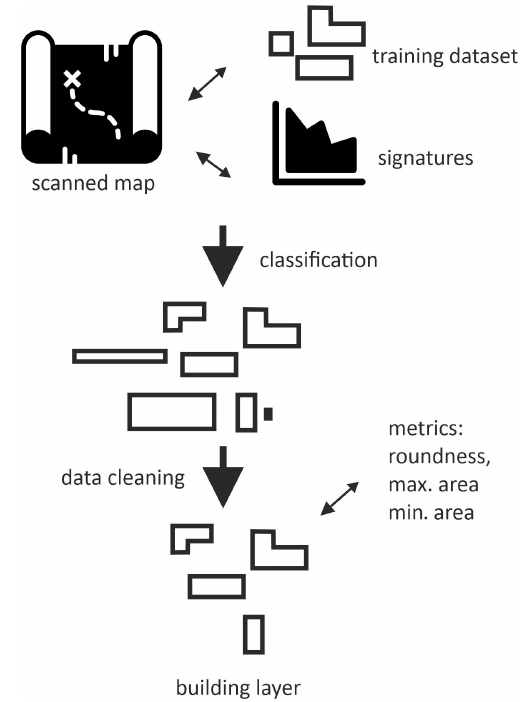
Figure 4. Semi-automatic procedure for acquiring residential build- ing structures (originally marked in red) from historical